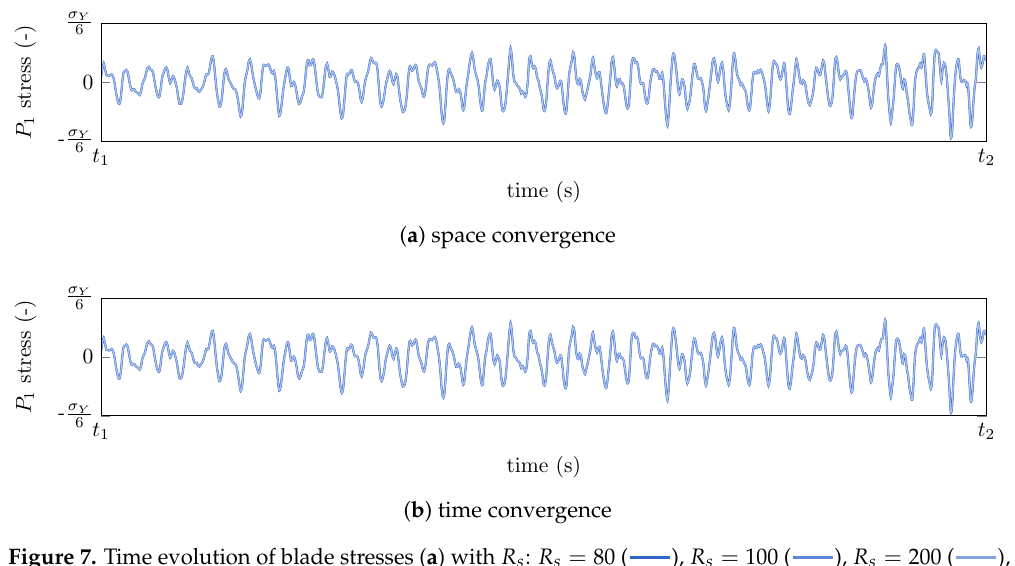
Figure 7. Time evolution of blade stresses ( a ) with R s : R s = 80 ( ), R s = 100 ( ), R s = 200 ( ), R s = 250 ( ), and ( b ) R t : R t = 1 ( ), R t = 500 ( ), R t = 1000 ( ), R t = 5000 ( ).